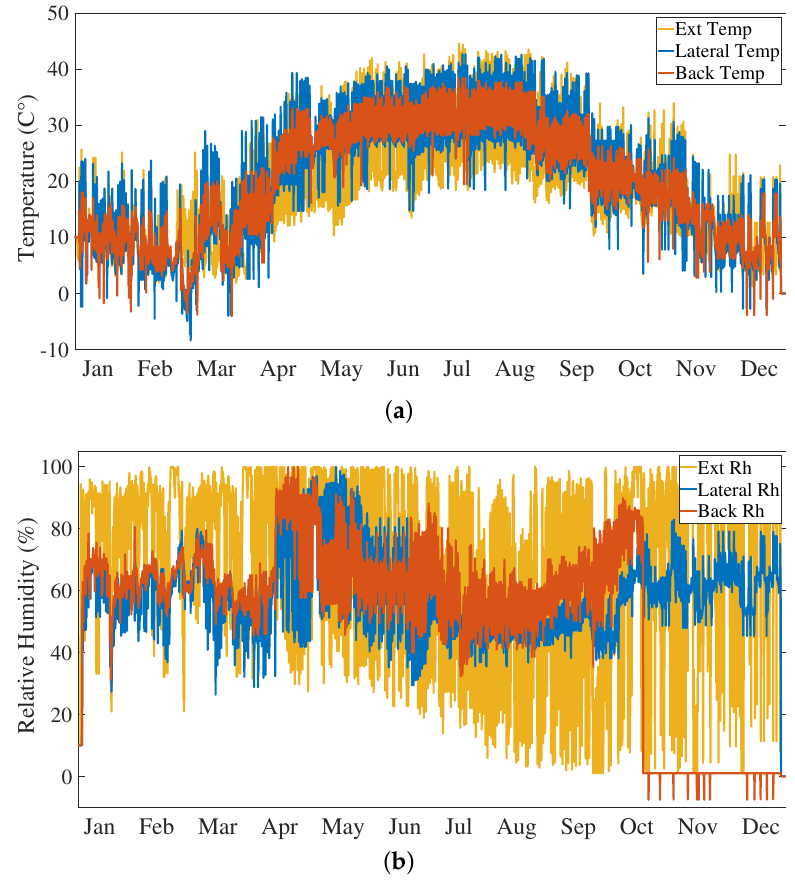
Figure 7. ( a ) Temperature and ( b ) relative humidity measurements during one year: in both cases, the first sensor is positioned on the inner lateral side of the hive (Lateral), the second sensor is positioned on the inner back side (Back), and the external sensor is positioned outside the hive